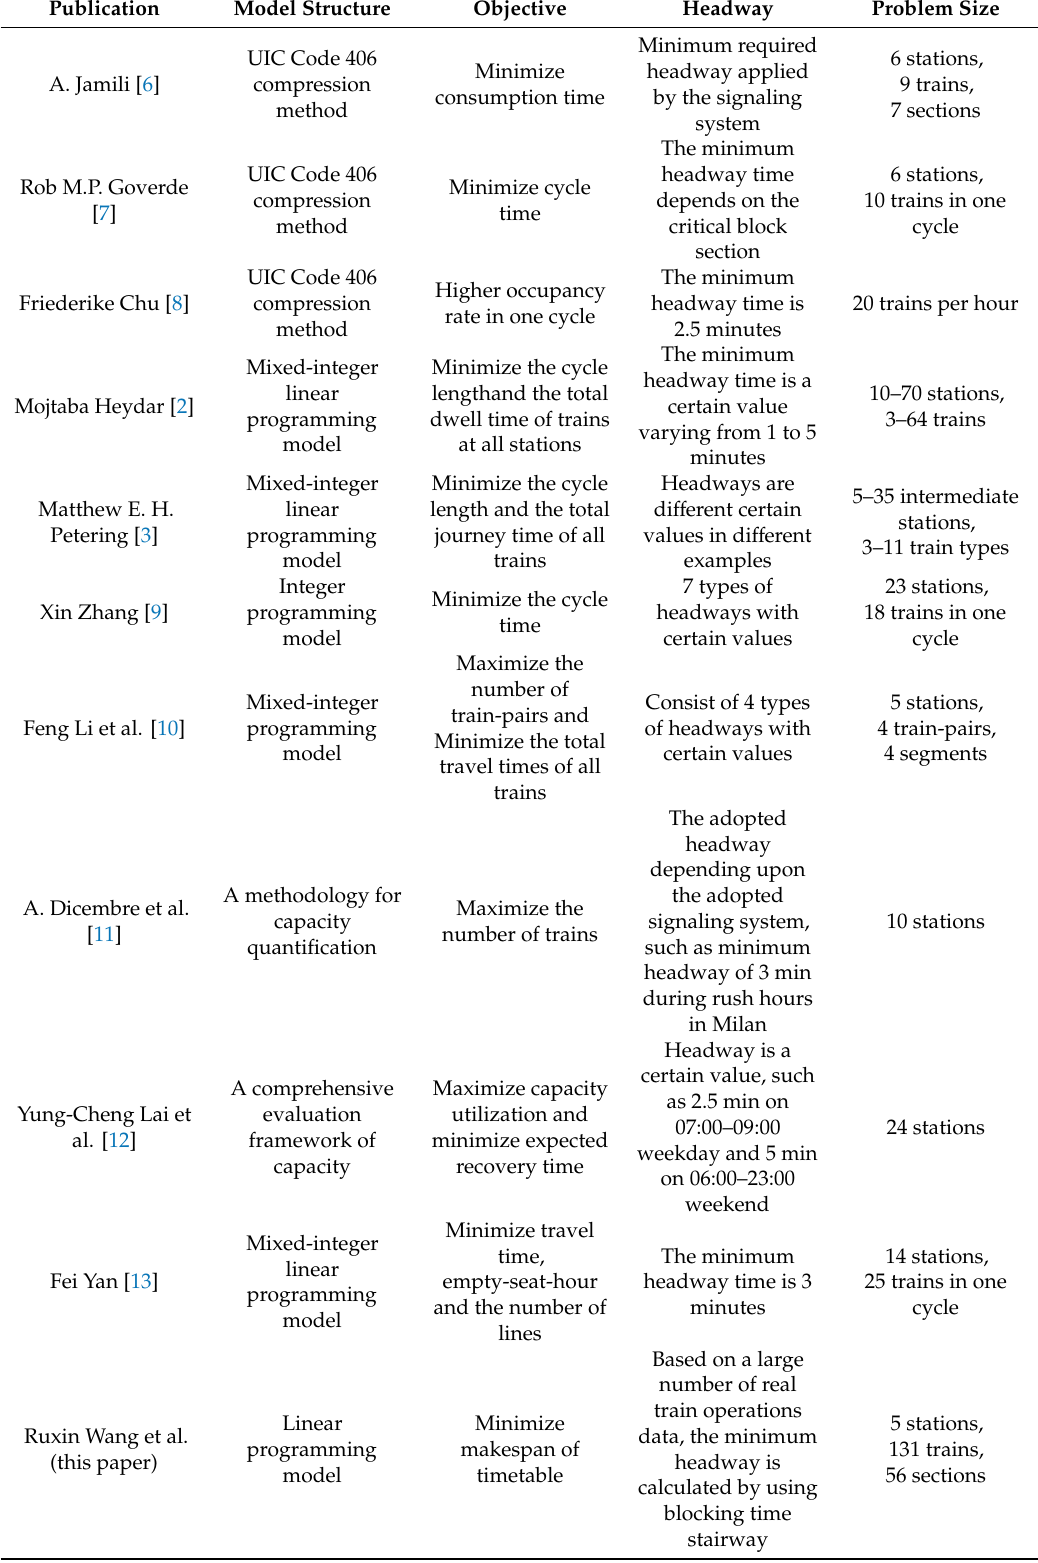
Table 1. Studies about the railway capacity evaluation and